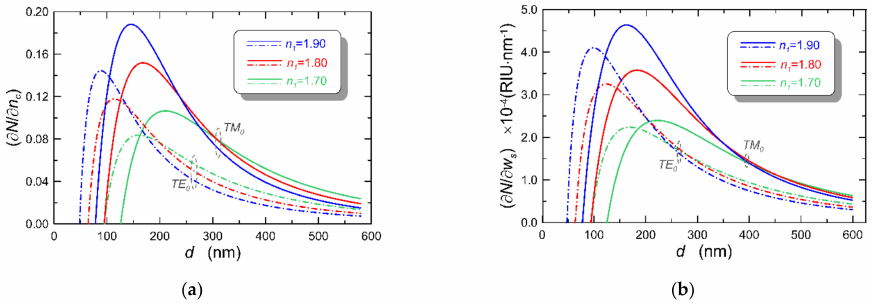
Figure 6. Influence of the thickness and refractive index of waveguide films on the homogeneous ( a ) and surface ( b ) sensitivity. The remaining parameters have the following values: n b = 1.510, n c = 1.333, n s = 1.500, w s = 1.0 nm, λ = 632.8 nm.